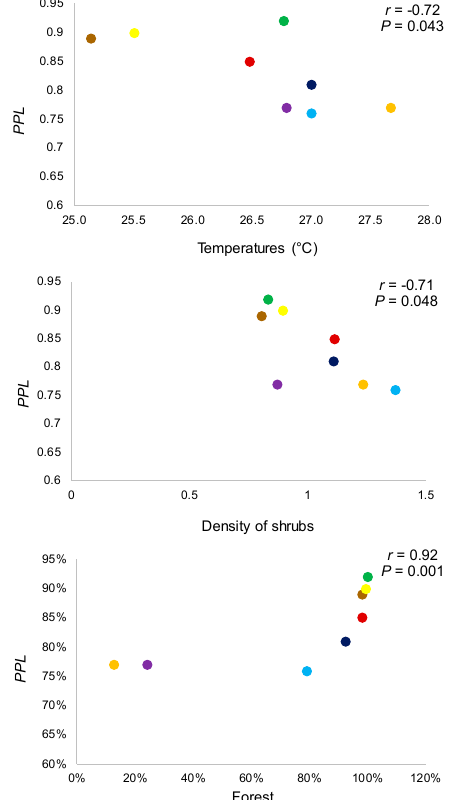
Figure 3. Significative correlation between genetic diversity ( PPL ) and land cover characteristics (temperature, density of shrubs, and forest). Colors represent localities: brown (Calakmul), dark blue (Kohunlich), light blue (Miguel Hidalgo), purple (Jardín Botanico), orange (Xcalak), yellow (Kiuic), green (Sian Ka’an), burgundy (Zapotal). Results of Spearman correlation: r and p .